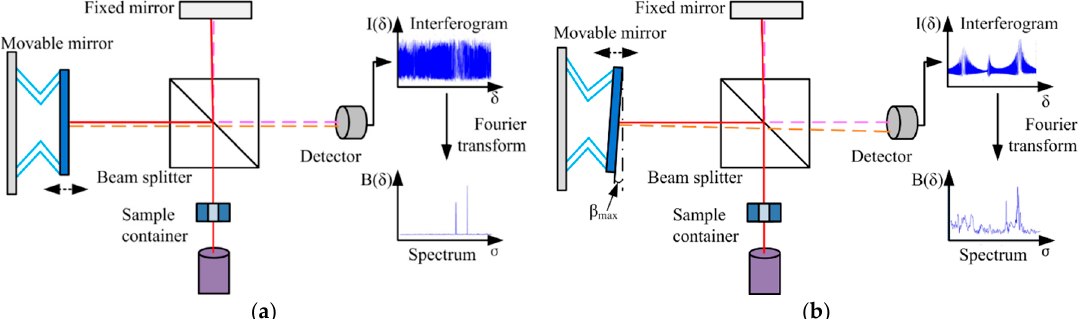
Figure 1. Schematic of a Michelson interferometer: ( a ) An ideal Michelson interferometer; ( b ) a Michelson interferometer with the movable mirror tilting.